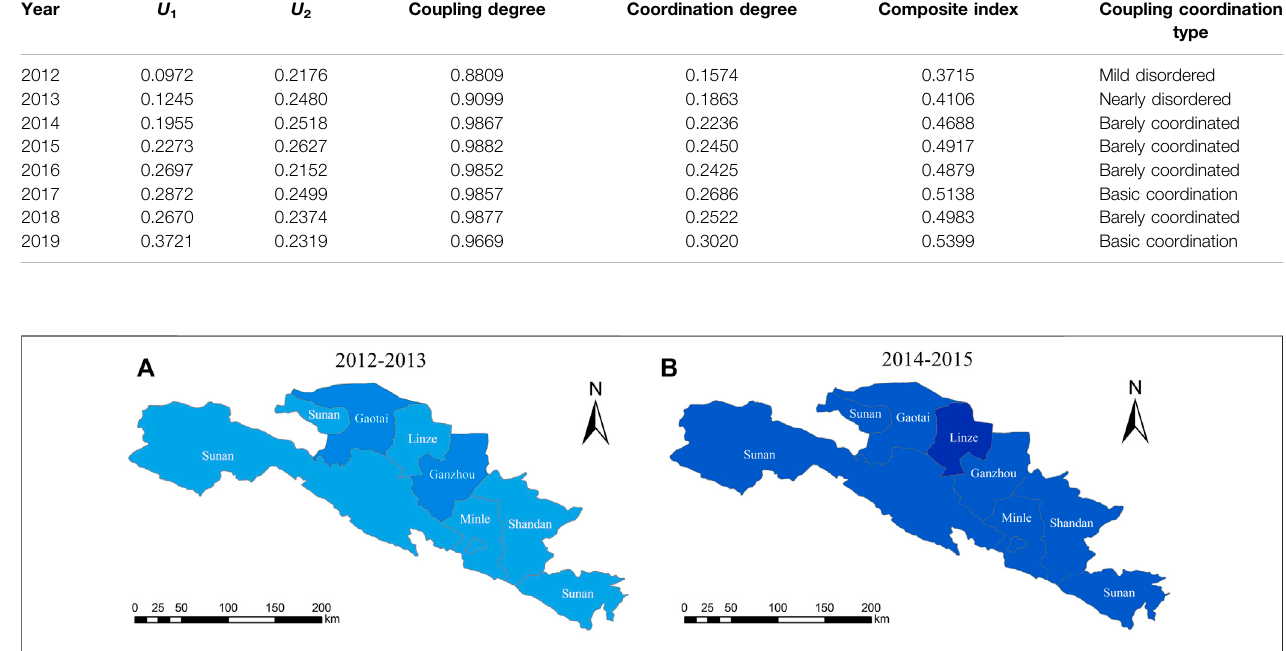
Frontiers in Environmental Science |